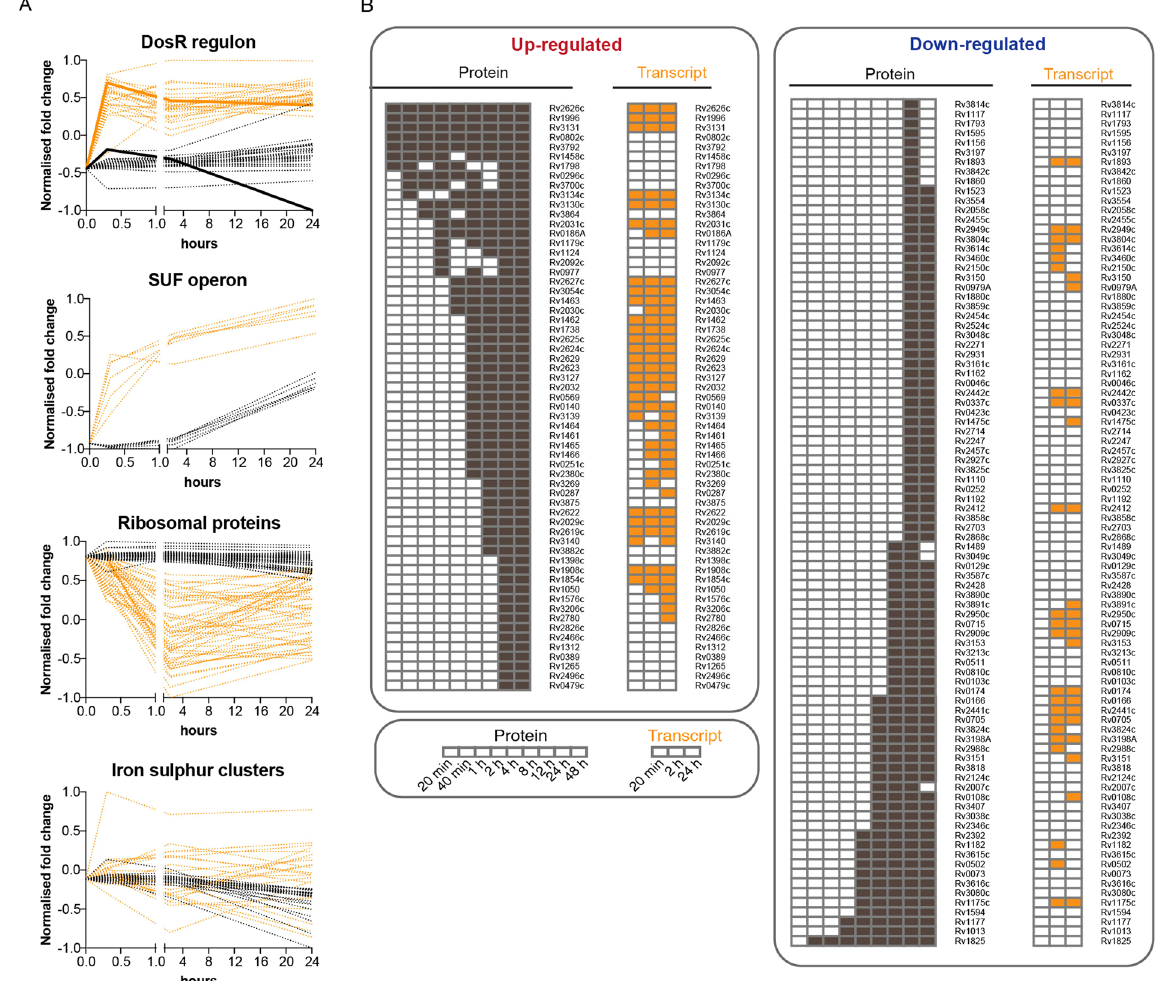
Figure 3. Role of transcriptional regulation for protein abundances during nitric oxide stress. ( A ) Line plots showing changes in transcript (orange) and protein (black) abundances over time in response to NO. The first panel shows the delayed induction of DosR proteins compared to the rapid transcriptional activation. The discordant response observed for FdxA (containing an iron-sulphur cluster) is highlighted with full lines. The second panel shows the delayed induction of proteins from the SUF operon. The third panel shows the delayed decrease in abundance of ribosomal proteins. The fourth panel shows the discordant response observed for proteins containing iron-sulphur clusters. In all panels, fold changes have been normalised so that the maximal and minimal fold change are 1 and minus 1, respectively. ( B ) Global dynamics of protein up-regulation and down-regulation in response to NO. Heat map shows the correlated dynamics of protein up-regulation and down-regulation with mRNA transcripts for the set of proteins with significant altered abundance 24 hours after exposure to NO. Black coloured cells indicate a significant change of protein abundance compared to time point 0 (log 2 fold change > 0.5; adjusted P-value < 0.01); white cells denote measurements that did not meet this threshold for differential expression. Right panels show the expression pattern at the mRNA transcript level. In this case, differentially expressed genes were called when log 2 fold change > 2 and adjusted P-value < 0.01 with significant changes indicated by orange coloured